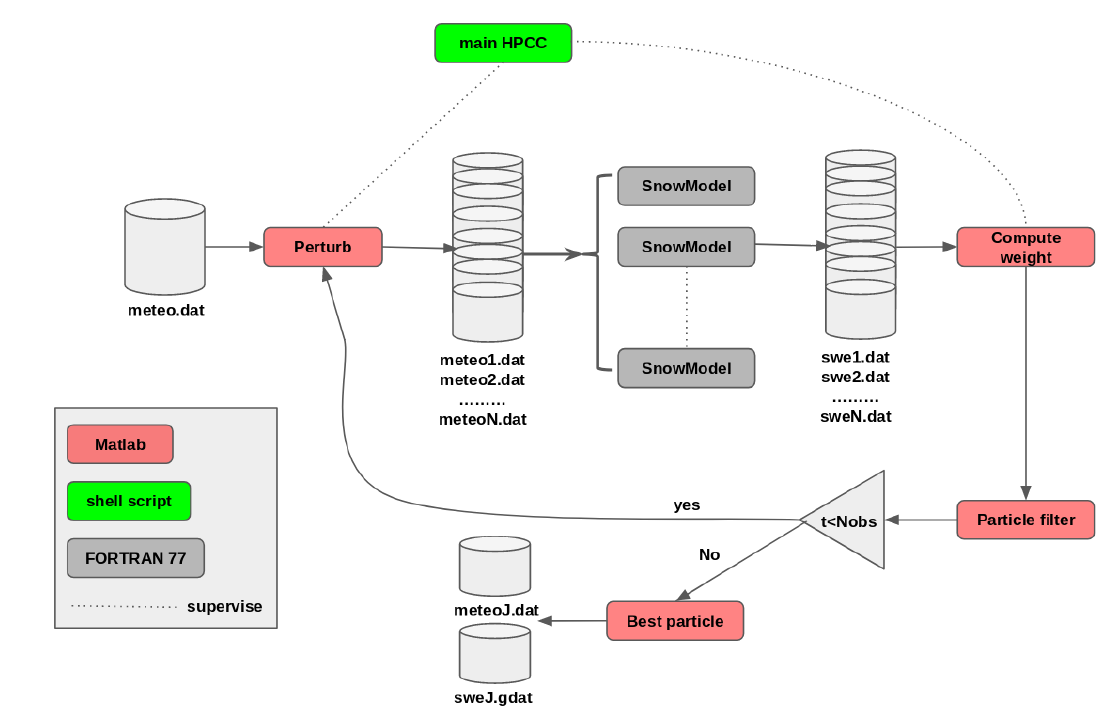
Figure 7. Description of the information technology (IT) implementation of the particle filter in this